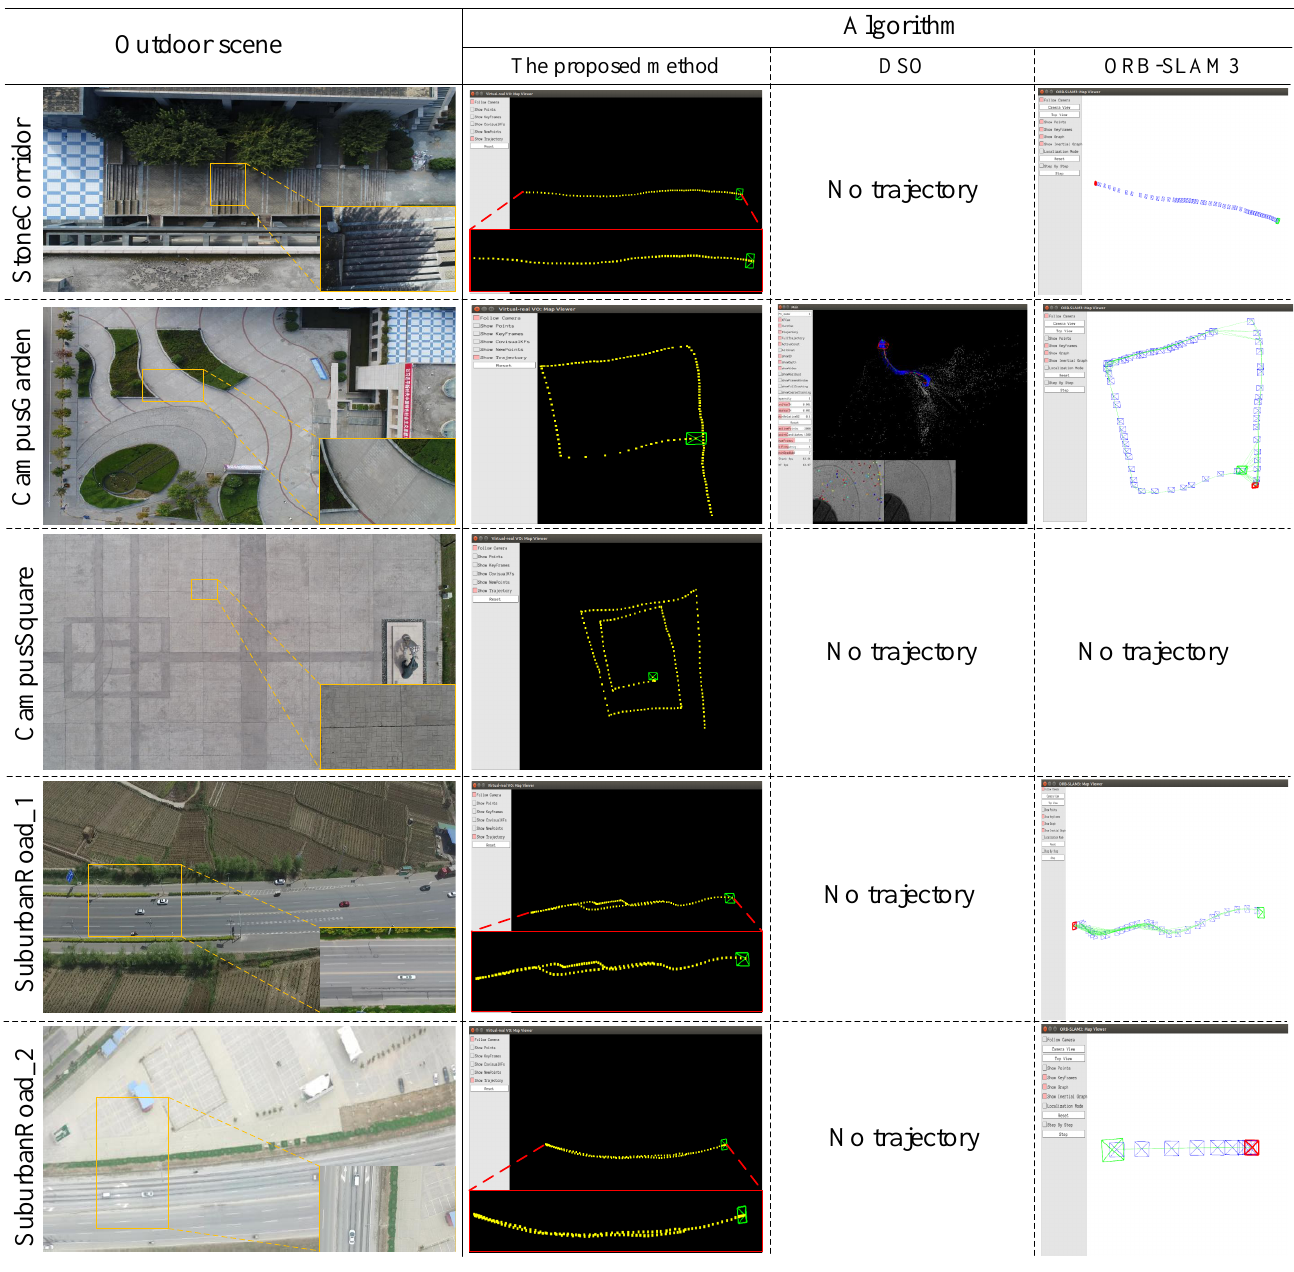
Figure 9. Qualitative comparison experiments of real outdoor scenes. For the results of our method, the yellow dots represent the UAV 3D positions, the green square represents the current pose of the UAV and the “zoom-in” views are shown in the red boxes. For the results of ORB-SLAM3, the blue camera shape pattern represents the pose of the keyframe. For the results of DSO, the green line represents the trajectory and the blue camera shape pattern represents the pose of the